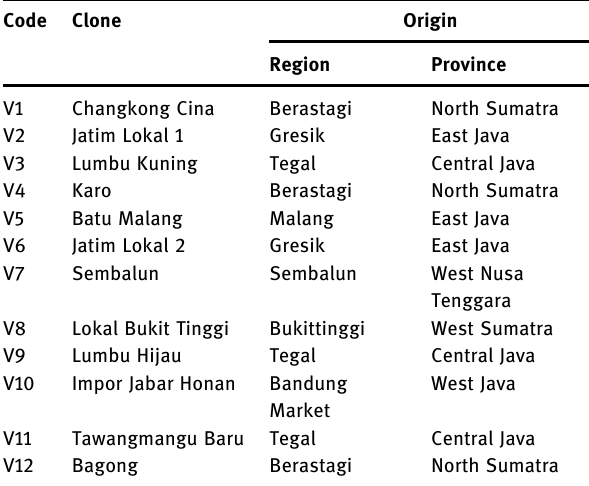
Table 2: Garlic varieties/clones used for the experiment Code